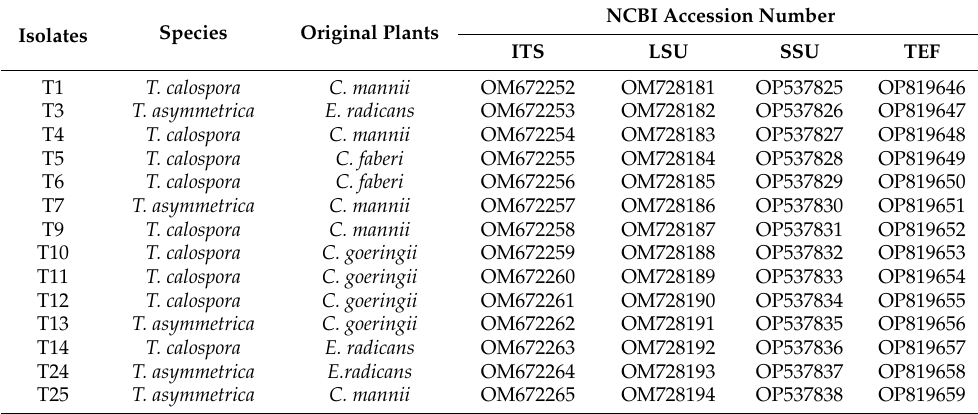
Table 1. NCBI registration number of fungal gene and orchid source of isolated fungus. Isolates Species Original Plants